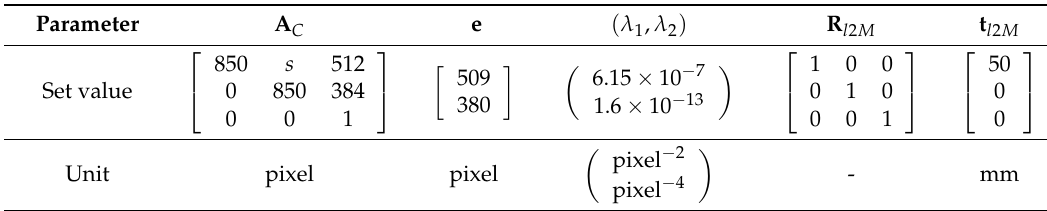
Table 2. System parameters of